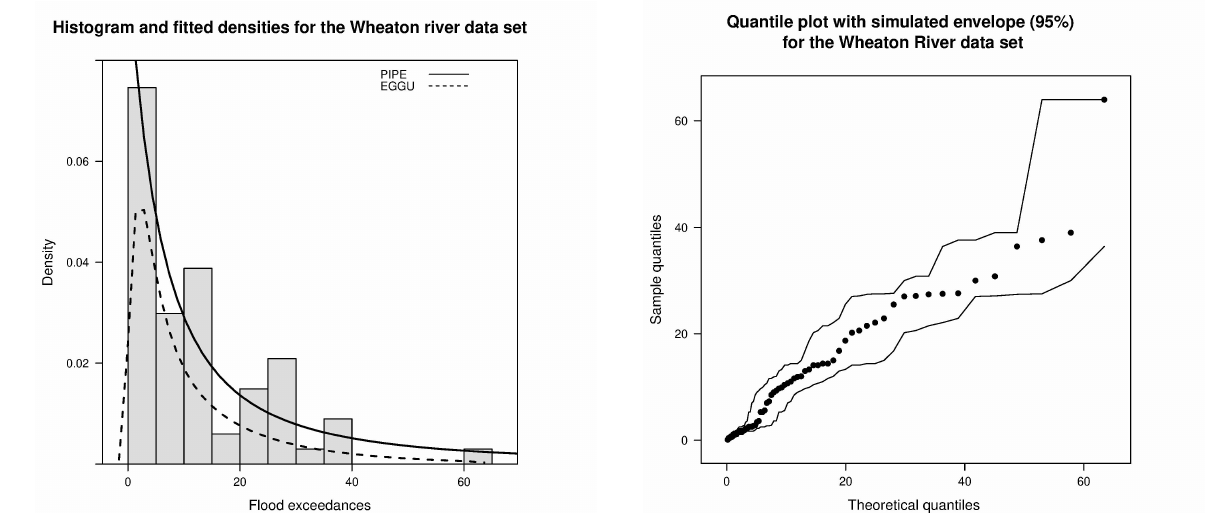
Figure 2. Histogram and quantile plot for the Wheaton river data